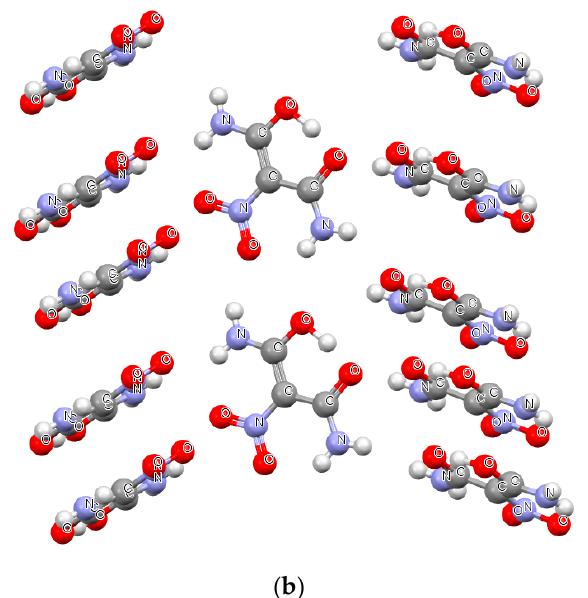
Figure 3. The fragments of crystal structures of ( a ) 2-cyano-4,4,5,5,6,6,6-heptafluoro-3-hydroxy-N- methyl-N-phenylhex-2-enamide [76], KAJTOG refcode; and ( b ) of 3-amino- 3-hydroxy-2-nitroprop-2-enamide [77], NMALAM01 refcode.